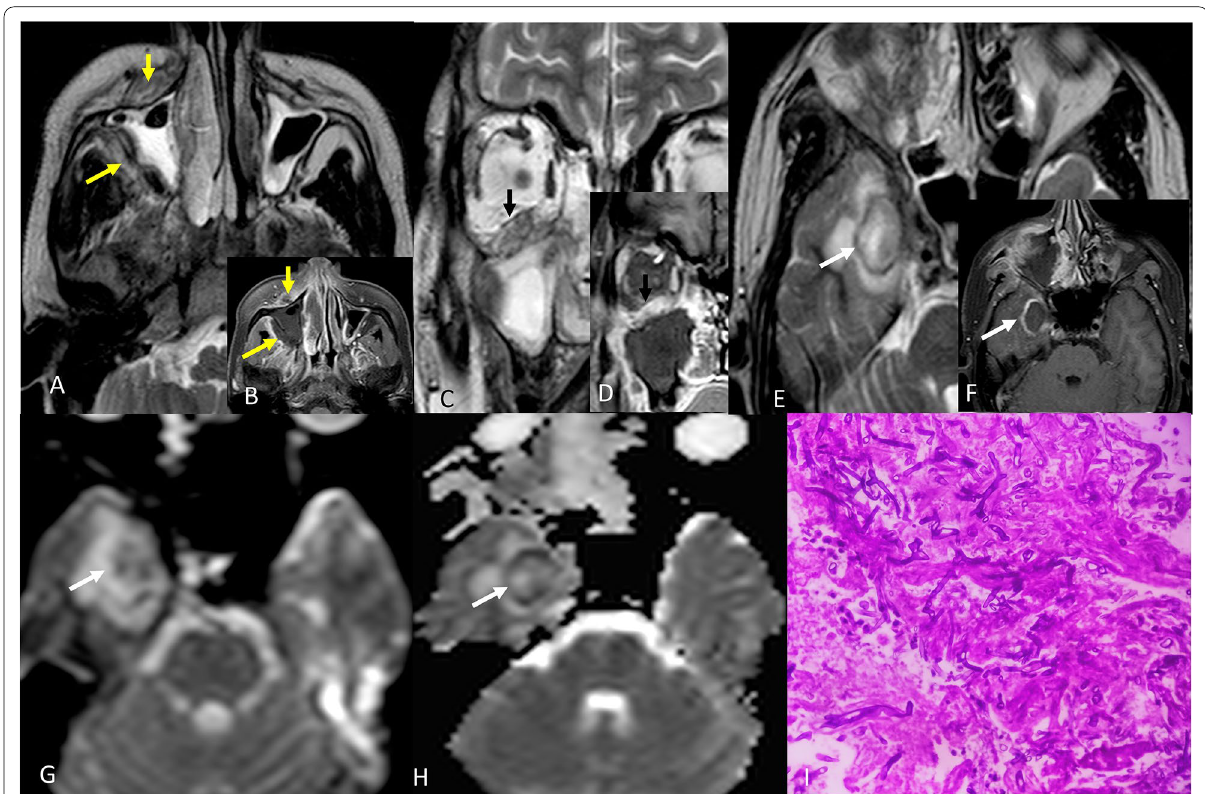
Fig. 9 A (T2 axial) and B (T1 post contrast axial) images show mucosal thickening and opacification in bilateral maxillary sinuses with hypertrophy of turbinates on right side along with involvement of anterior and posterior periantral fat (yellow arrows) on right side with contiguous involvement of infratemporal fossa. C (T2 coronal), D (T1 post contrast coronal) images show involvement of inferior rectus muscle and fat stranding in right orbit. E (T2 axial), F (T1 post contrast axial) images of brain showing an abscess in right temporal lobe with hypointense wall on T2W image showing post contrast enhancement (white arrows). The wall of the abscess shows restriction of diffusion on DWI ( G ) with loss of signal intensity on ADC image ( H ). The internal contents do not show restriction of diffusion, suggesting fungal abscess. I Microphotograph from debrided material showing aseptate fungal hyphae seen in the necrotic material likely to be mucormycosis (H&E stain